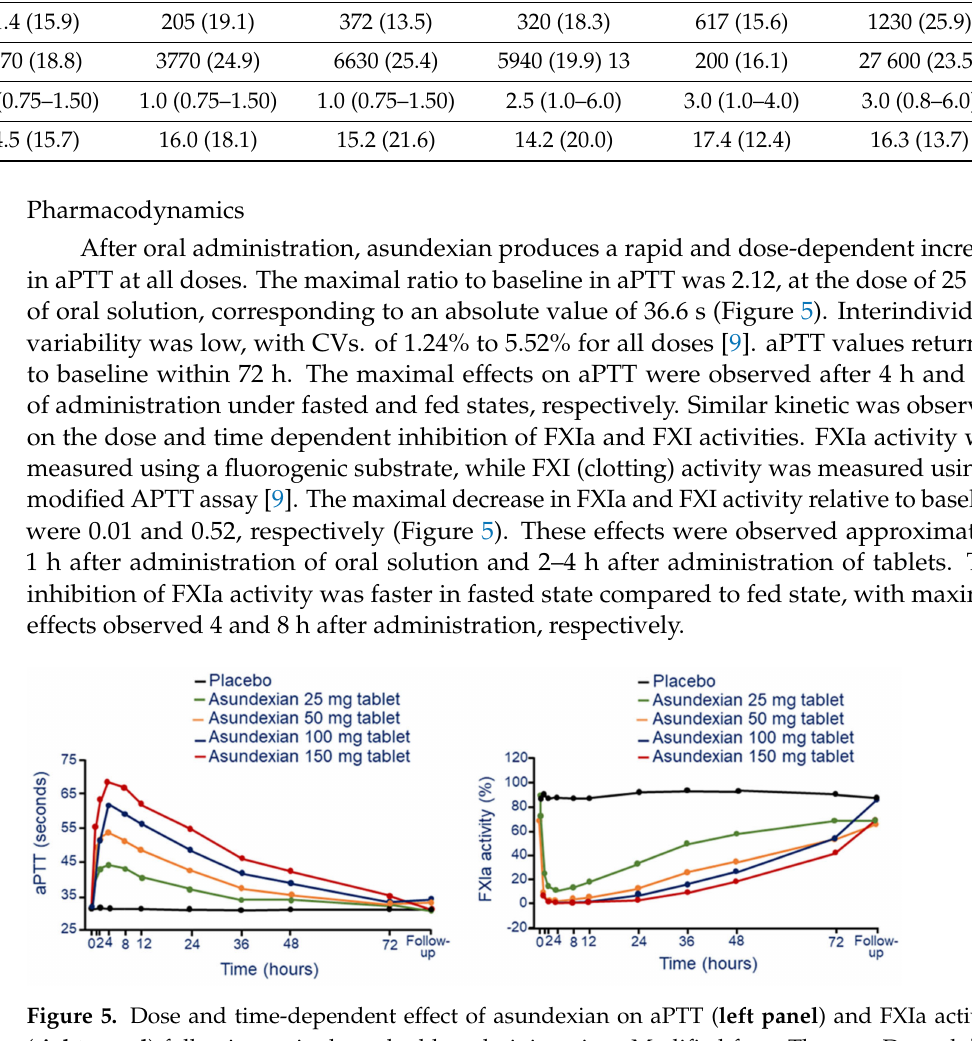
Figure 5. Dose and time-dependent effect of asundexian on aPTT ( left panel ) and FXIa activity ( right panel ) following a single oral tablet administration. Modified from Thomas, D. et al. [29]. F: factor; aPTT: activated partial thromboplastin